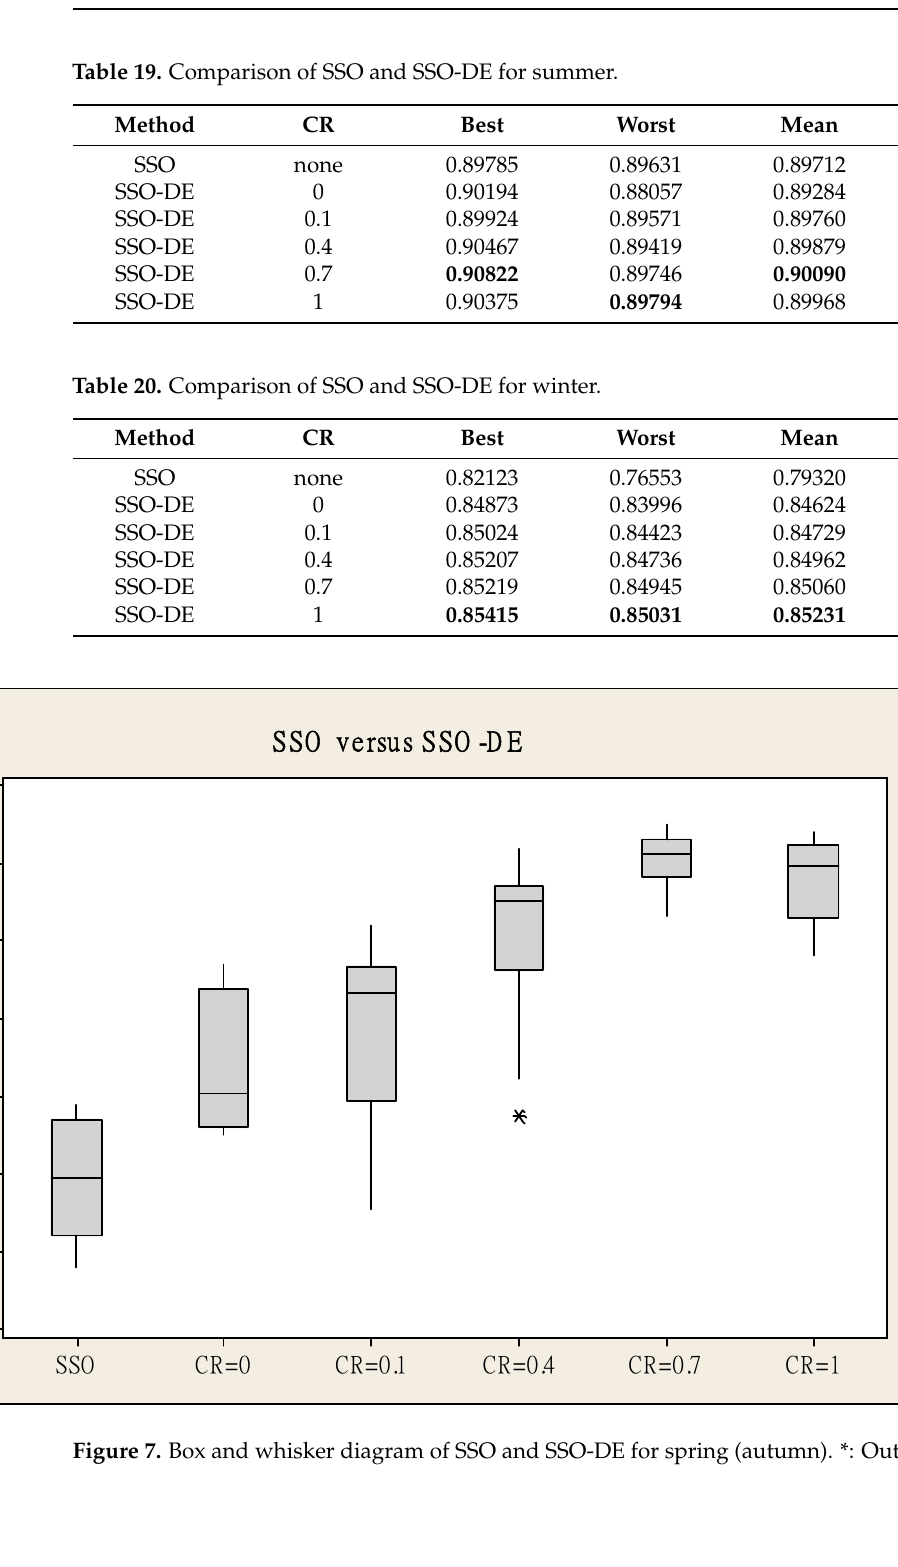
Table 19. Comparison of SSO and SSO-DE for summer.